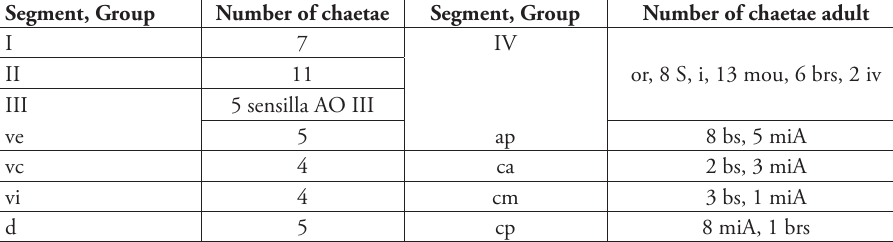
Table 3b. Chaetotaxy of Yuukianura deharvengi sp. n.: chaetotaxy of antennae. Segment,